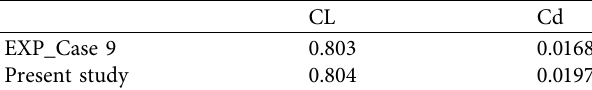
Table 2: Steady results of Case 9 and the present study.